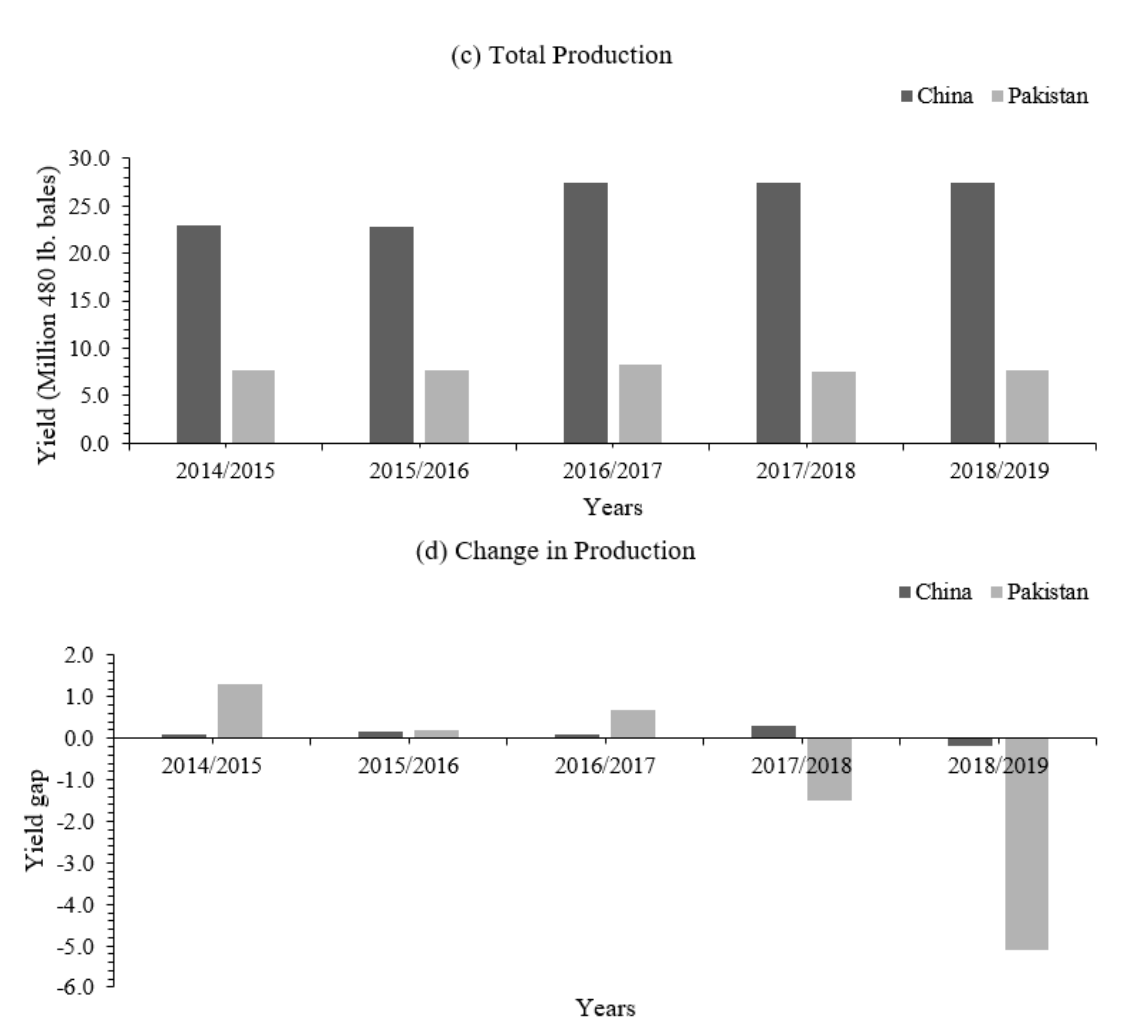
Figure 7. Yearly assessment of Pakistan and China ( a ) cotton production area (million hectares); ( b ) production (million Figure 7 bales); ( c ) yield (kg/hectare); ( d ) trends of change in production during growing seasons of 2015–2019, where 2018/2019 are predicted values on the basis of the previous data